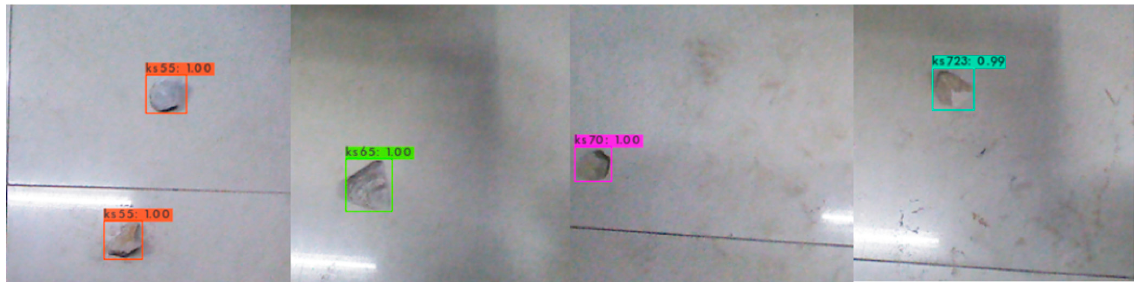
Figure 8. Corresponding test results of four